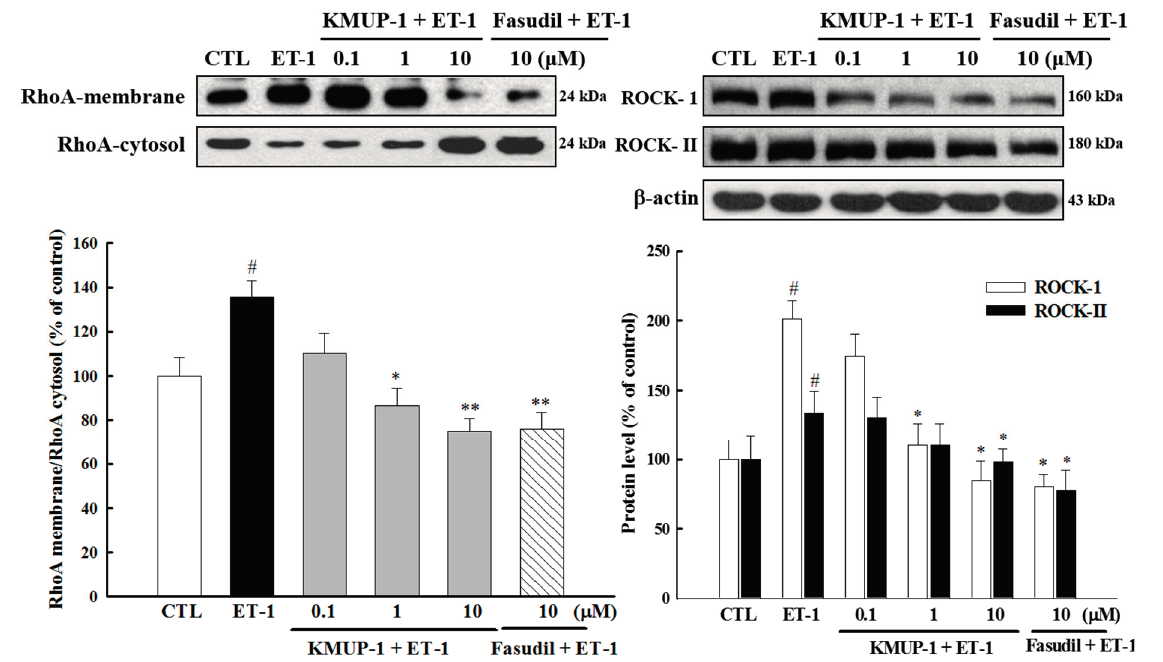
Figure 6. Effects of KMUP-1 on the RhoA/ROCK pathway. H9c2 cells were pretreated with different doses of KMUP-1 for 1 h, followed by co-treatment with 100 nM ET-1 for 30 min. The expression levels of Rho-kinase (ROCK-1 and ROCK-2) and ET-1-induced RhoA translocation were markedly attenuated by KMUP-1 and Fasudil (10 μ M). Each value represents the mean ± SEM of three independent experiments, with triplicate determinations in each experiment. # p < 0.01 compared with control; * p < 0.05, ** p < 0.01 compared with ET-1